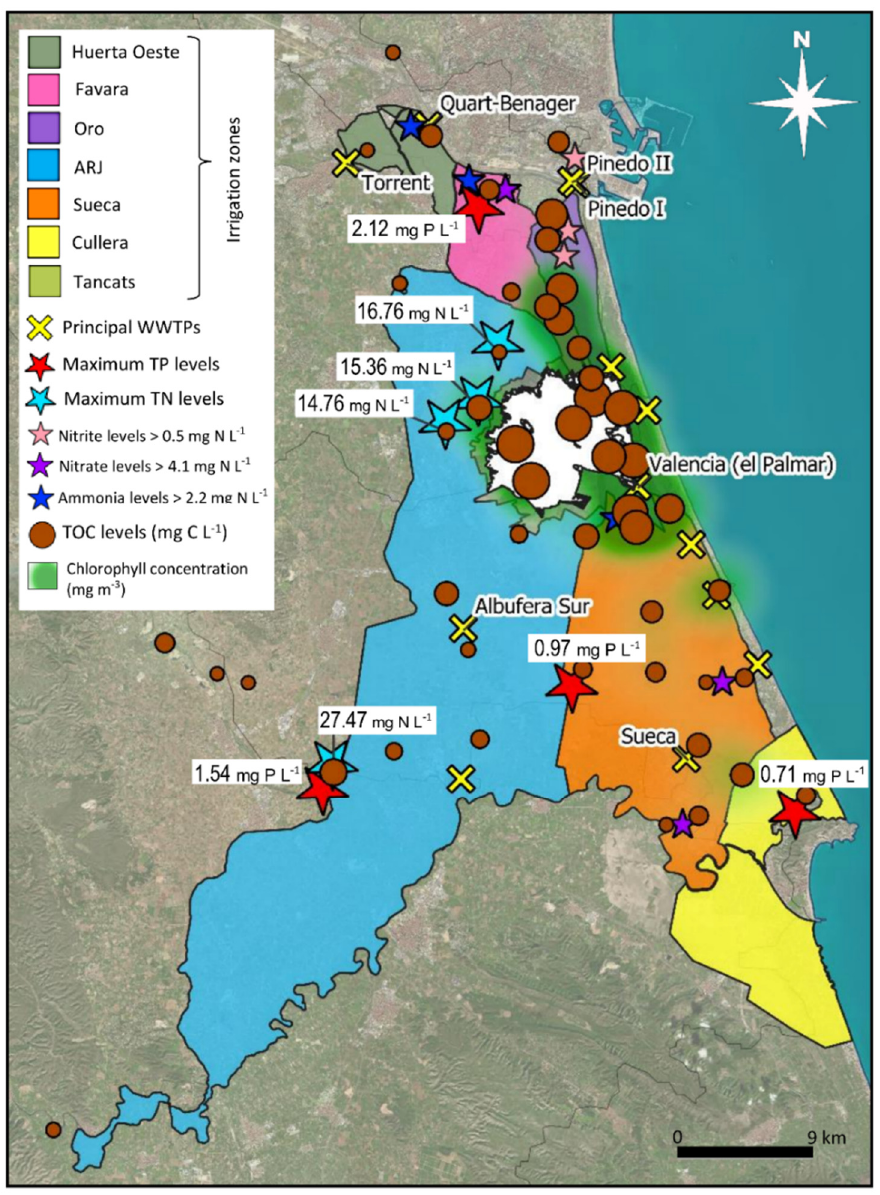
Figure 2. Agricultural (irrigation zones) and urban contextualization of the study area and spatial representation of the maximum levels of TP, TN, nitrite, nitrate and ammonium nitrogen together with the average concentrations of TOC and phytoplanktonic chlorophyll a. Base image: OrtoPNOA 2018 CC-BY 4.0 scne.es.